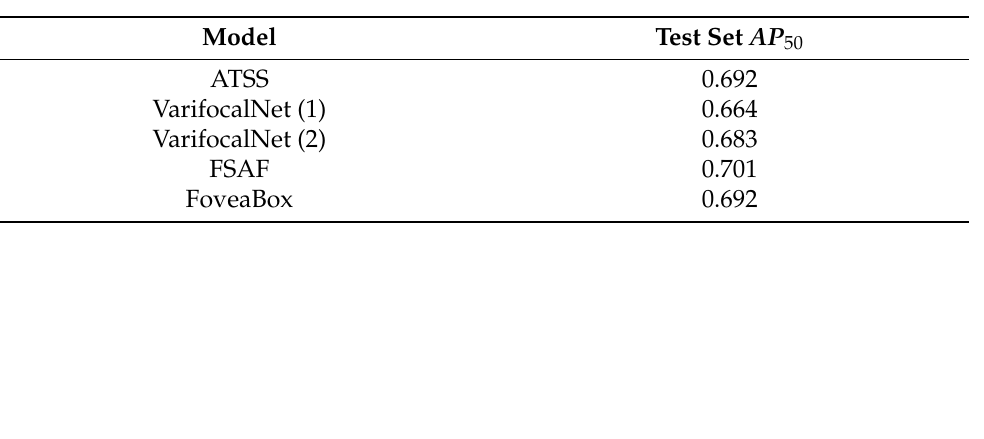
Table 5. Performance of the anchor-free (AF) methods on the test set using AP 50